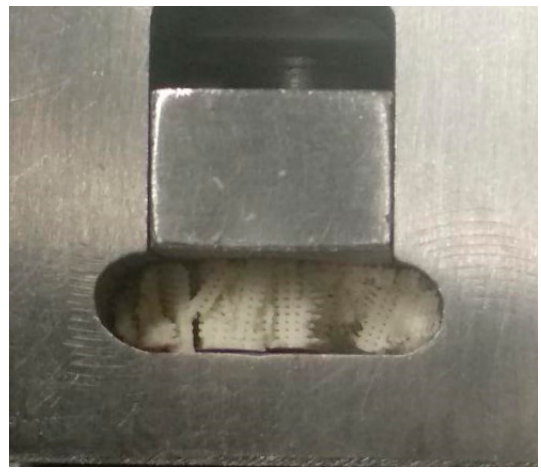
Figure 11. Remaining columnar parts of a collapsed 3D porous structure within the in-situ compression test device.